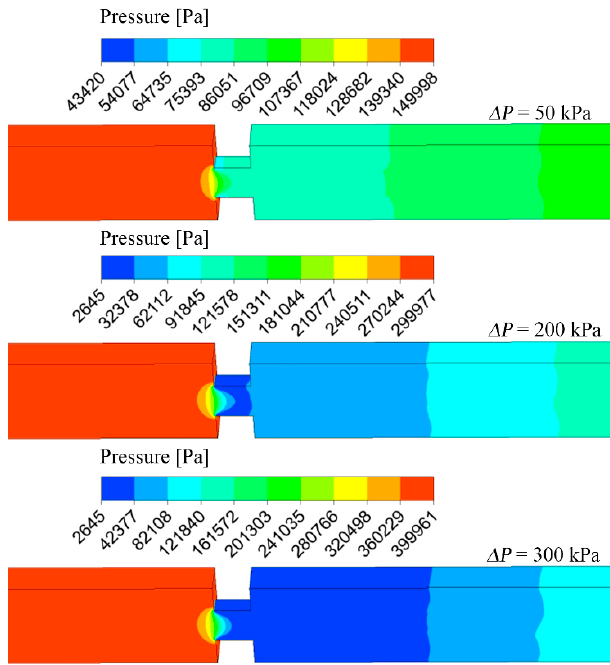
Figure 5. Pressure distribution inside the microchannel.